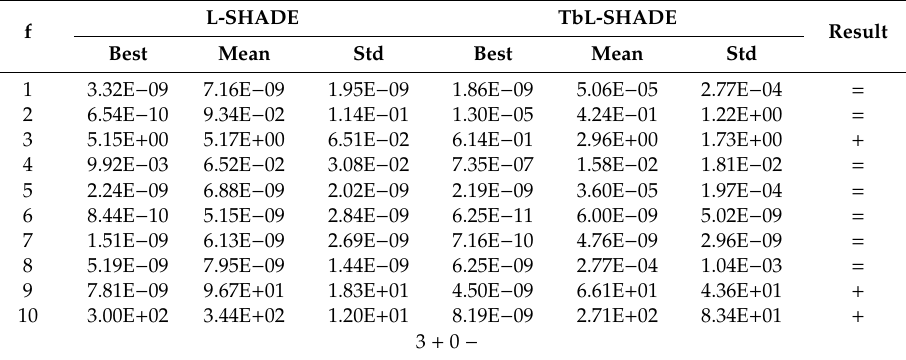
Table 11. L-SHADE vs. TbL-SHADE on CEC2020 in 5 D .